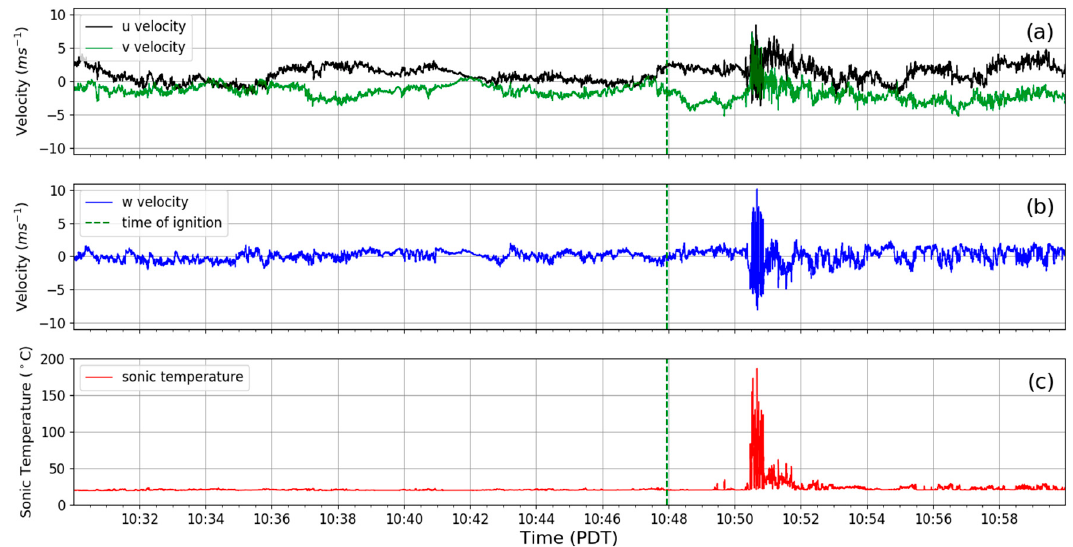
Figure 10. Time series of 12-m u and v wind velocities ( a ), w , vertical velocity ( b ), and sonic temperature, T s ( c ). The vertical dashed line indicates the time of ignition.